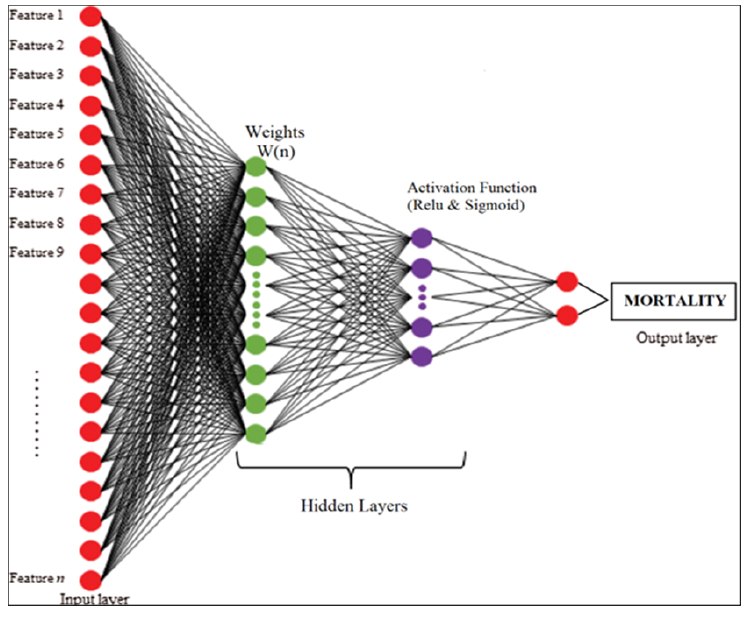
Figure 5. Architecture of DNN.